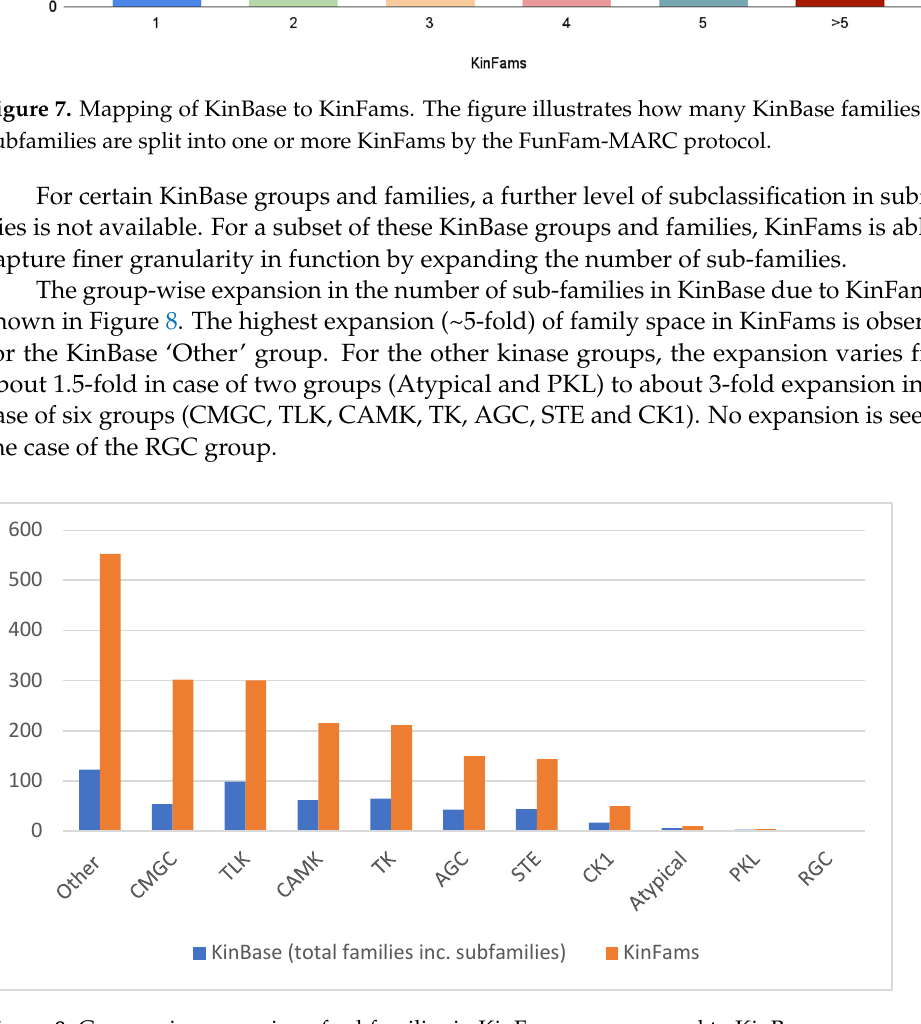
Figure 8. Group-wise expansion of subfamilies in KinFams, as compared to KinBase.